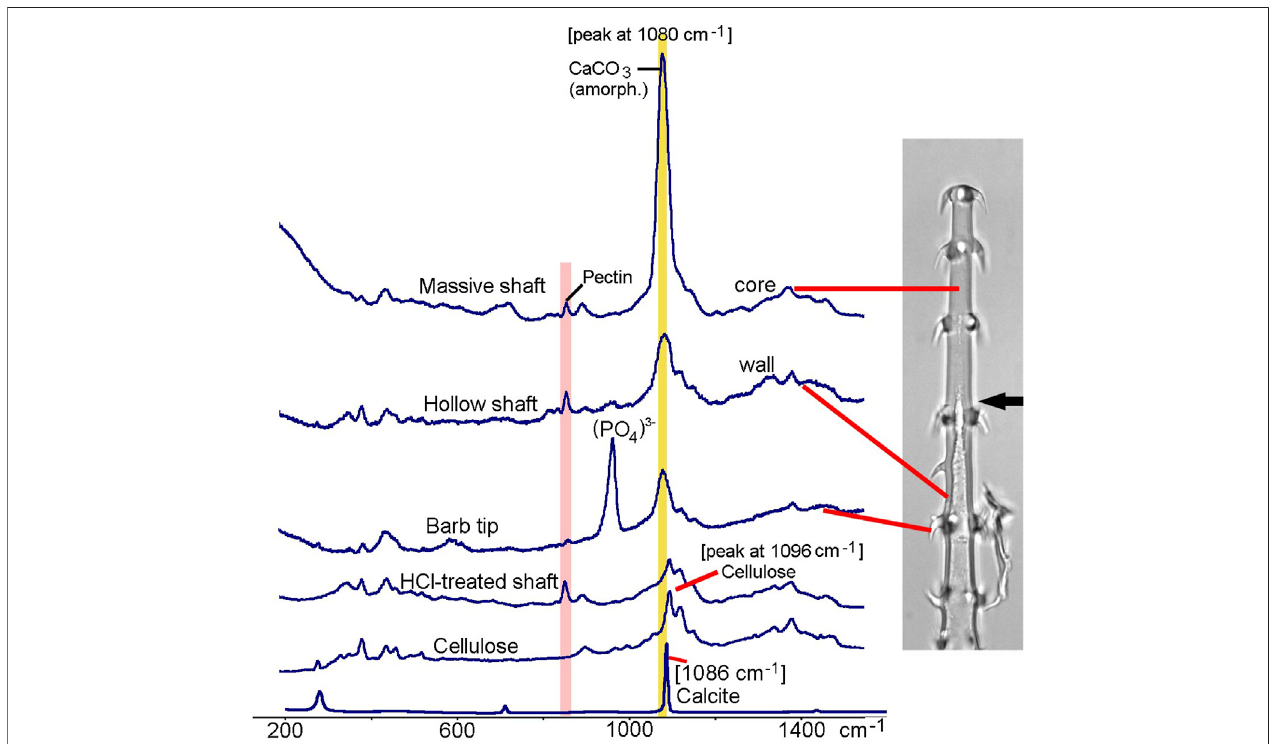
FIGURE6| Loasapallida , Raman spectroscopyanalyses ofglochidiate trichomes. Raman spectra ofcoreofmassiveshaft, wallofhollowshaft, abarb tip, and for comparison spectra from a demineralized, HCl-treated trichome and from cellulose and calcite. The broad carbonate peak at 1080 cm − 1 , which overlaps with the main Raman band of cellulose at 1096 cm − 1 , indicates amorphous or disordered calcium carbonate, with high concentration particularly in the core. A peak at 856 cm − 1 indicatesPectinwhichispresentintrichomewallsevenafterHCltreatment.Barbtipsshowanintensephosphatepeakat958 cm − 1 andsmallercarbonatepeakat 1080 cm − 1 . HCl-treated trichomes show Raman bands typical for carbohydrates such as cellulose and pectin.